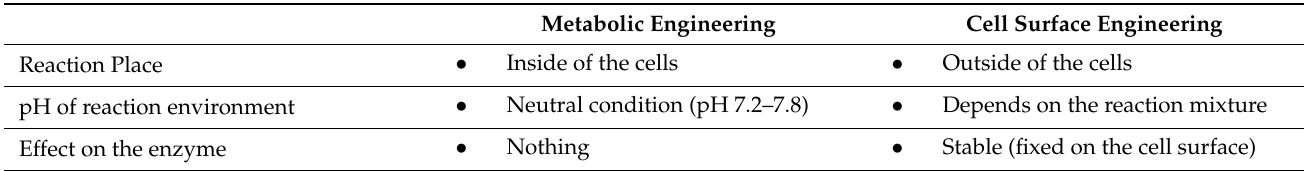
Table 1. Summary of biological methods for ammonia production. Metabolic